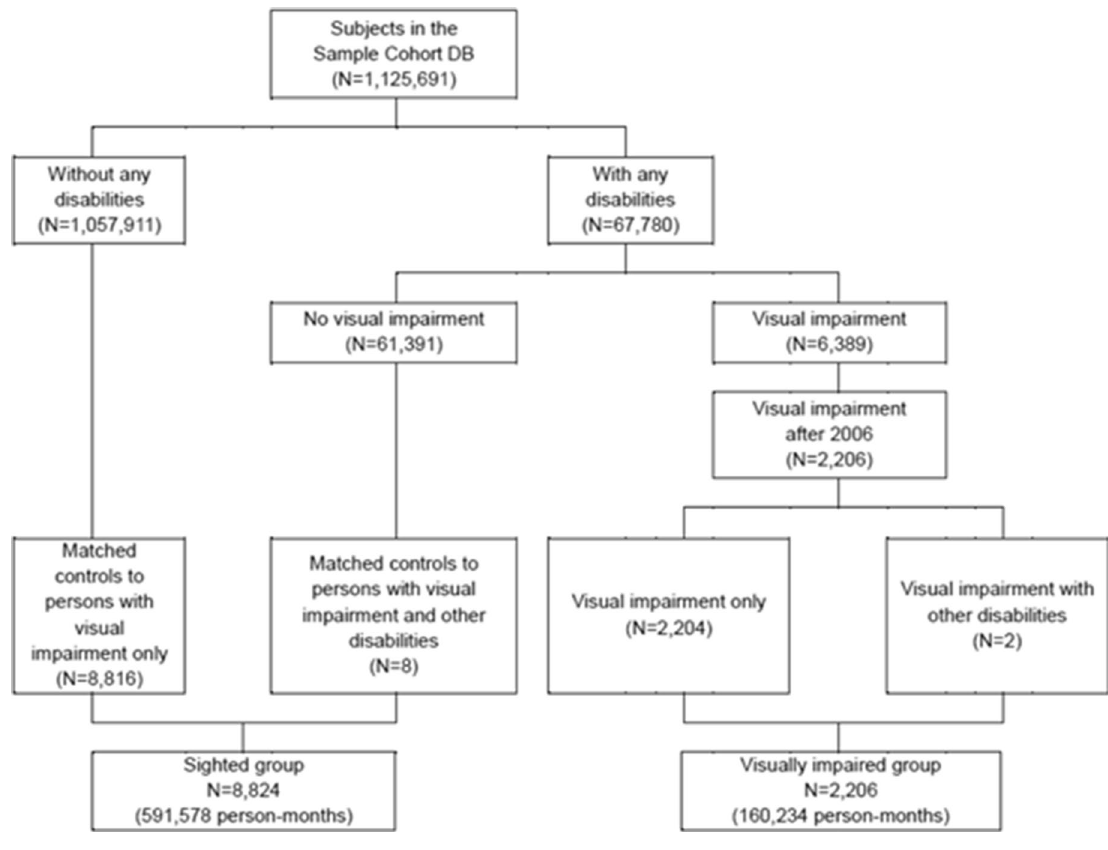
Figure 3. Sample selection